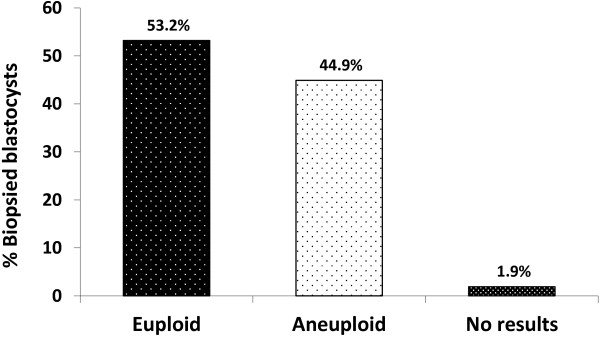
A summary of aCGH results derived from biopsied blastocysts (n = 425) in the morphology assessment plus aCGH screening group. No results = no results due to DNA amplification failure.